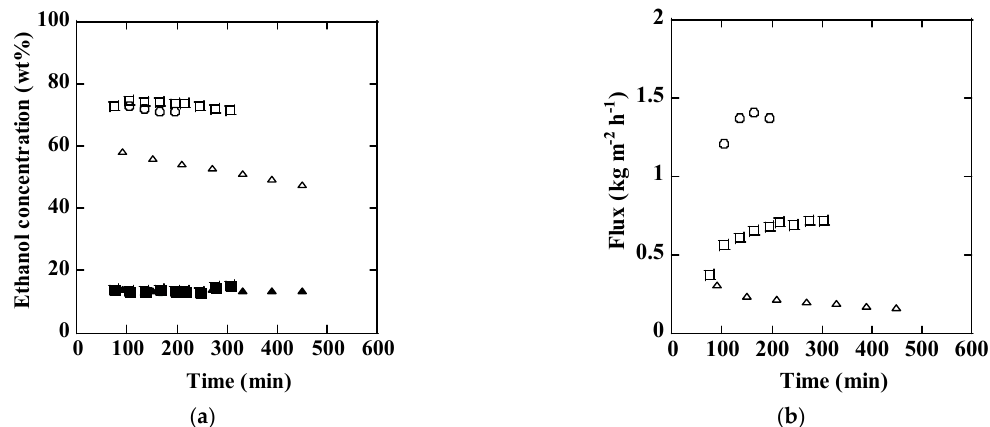
Figure 8. Changes of silicalite membrane permselectivity with time in a synthetic mixture and in a distillate of fermented broth measured at 348 K: ( a ), ethanol concentration in the feed and in the permeate; ( b ), flux as a function of time; ○ , a synthetic mixture of 14 wt% ethanol as feed measured before the distillate separation; △ , distillate as feed; □ , a synthetic mixture of 14 wt% ethanol as feed measured after the distillate separation; open keys, permeate concentration and flux; closed keys, feed concentration.